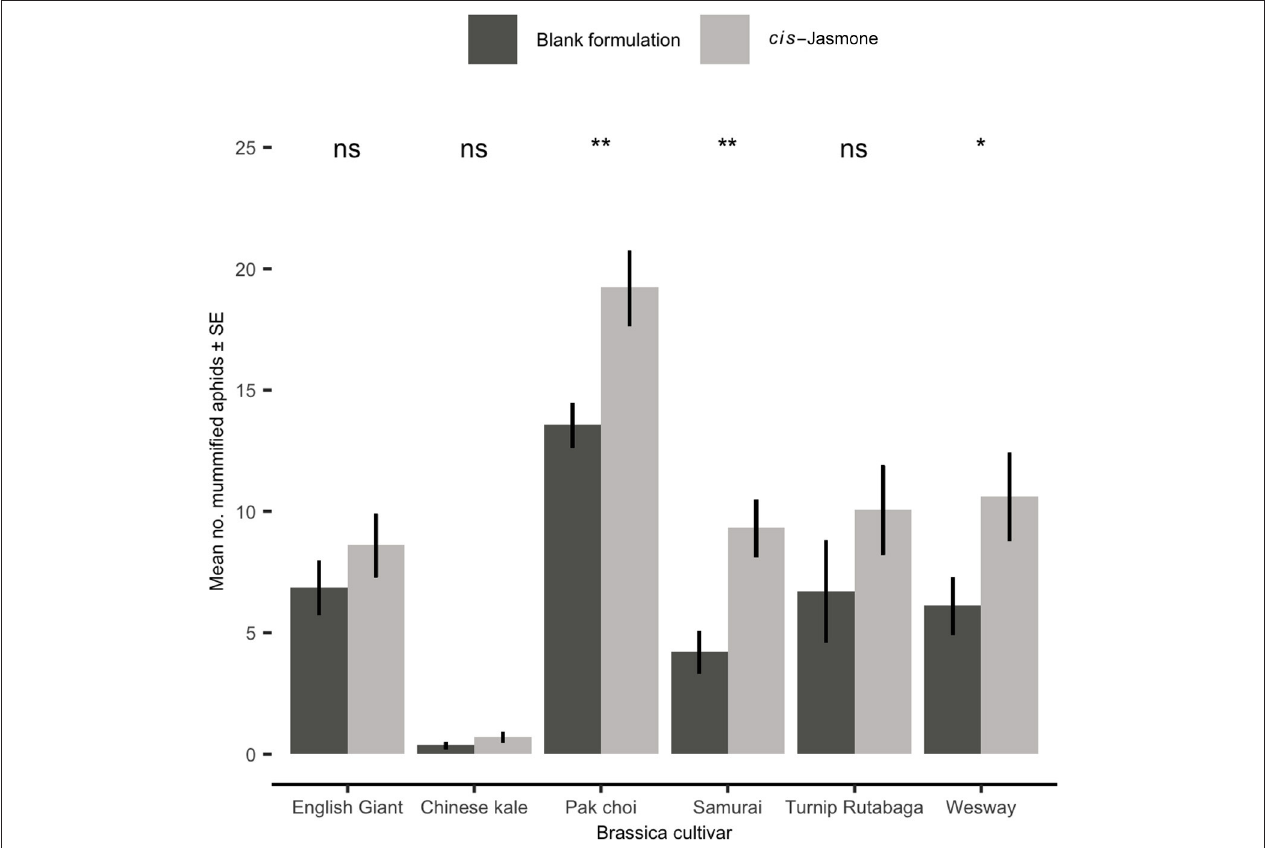
FIGURE 5 | Mean number ( ± SE) of mummified Myzus persicae on blank formulation (control) and cis- jasmone treated plants 15 days after exposure to Diaeretiella rapae for 2h ( n = 10). Brassica cultivars capped with “ns” do not show a significant difference between control and CJ treatment while asterisks denote differing levels of statistical significance: * < 0.05 and ** < 0.01 (generalised linear models with either Poisson or quasi-Poisson probability